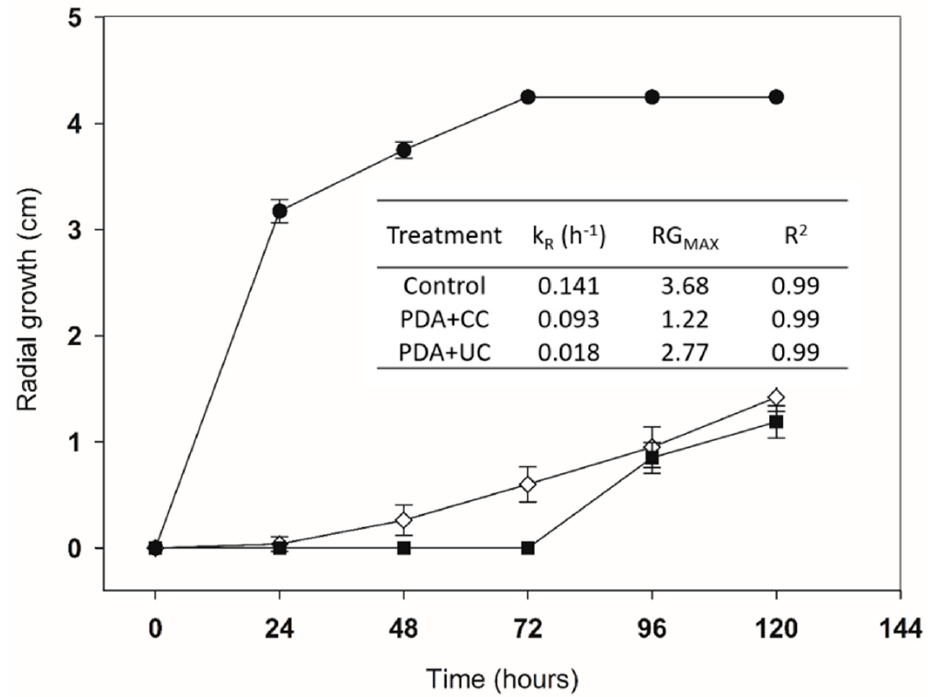
Figure 4. ( ● ) Radial growth of P. ultimum in control medium (PDA); P. ultimum radial growth in PDA medium using ( ◊ ) 2.5 g/L UC and ( ■ ) 2.5 g/L CC, and presentation of kinetics parameters of radial growth estimated by the Gompertz model.